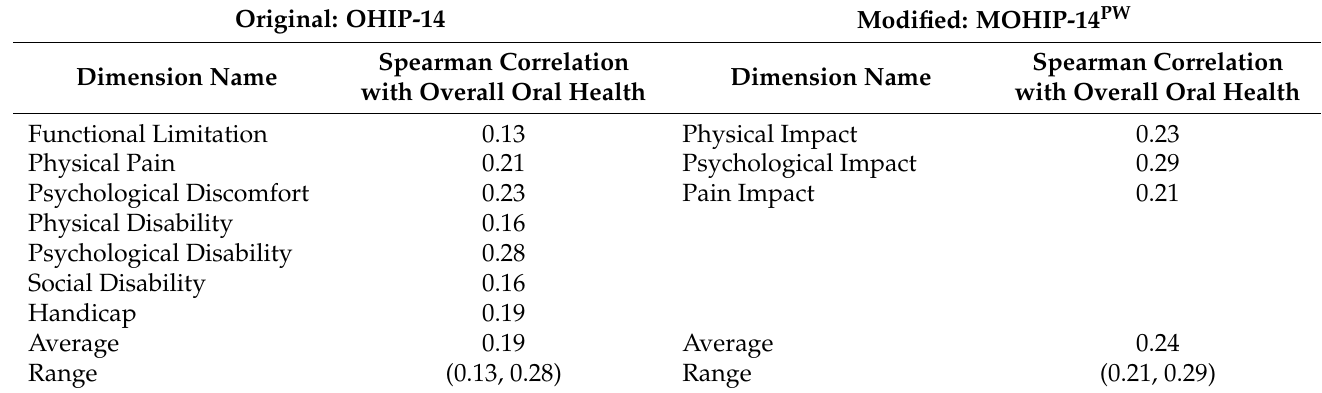
Table 5. Comparisons of the relationship of overall oral health with dimension scores from OHIP-14 versus MOHIP-14 in pregnant women (MOHIP-14 PW